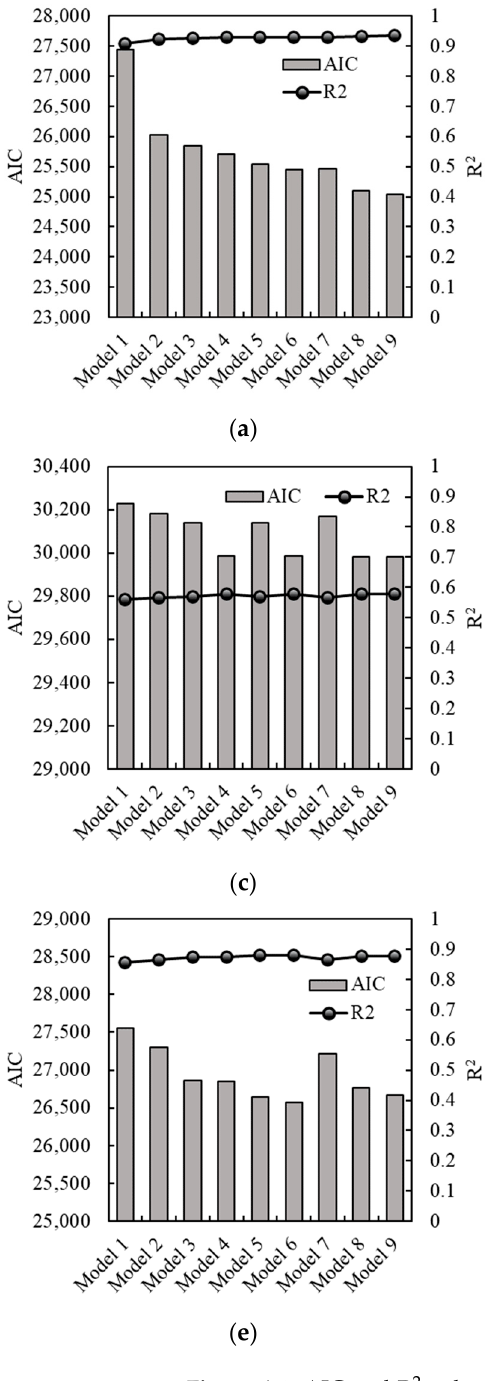
Figure A4. AIC and R 2 values of LR and MLR calibration models during the ( a ) dry and ( b ) wet seasons at CM, ( c ) dry and ( d ) wet seasons at BKK and ( e ) dry and ( f ) wet seasons at URT.